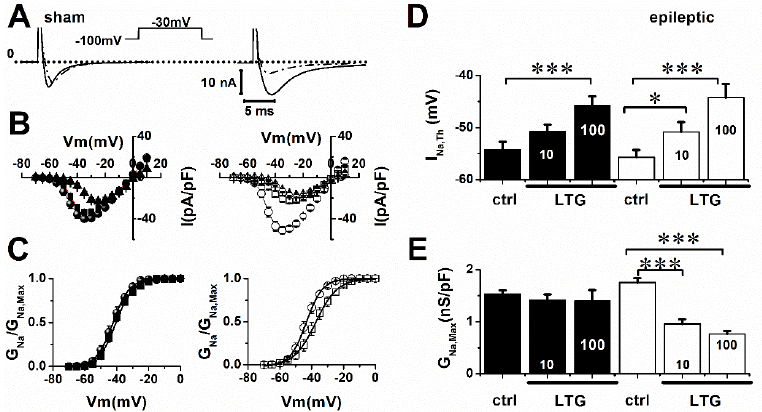
Figure 1. LTG blockade of I Na is increased during epilepsy. ( A ) Inset: voltage clamp protocol. I Na currents were activated by 25 ms voltage steps from −70 to 10 mV, in 5 mV increments, from a −100 mV holding potential. Representative I Na recordings from sham and epileptic rat ventricular cardiomyocytes in control conditions (solid line), and in presence of 10 µmol/L of LTG (dash-dot line). ( B ) Current – voltage relationships (I/V) for sham (filled symbol) and epileptic (open) animals in control conditions (circle), 10 µmol/L (square) and 100 µmol/L of LTG (triangle). ( C ) Normalized I Na activation curves for control and 10 µmol/L of LTG. Data points (±SEM) were fitted to a Boltzmann equation (solid lines). ( D ) LTG (10 µ mol/L) depolarized I Na voltage threshold (I Na,Th ) only in epileptic animals, while 100 µ mol/L of LTG significantly depolarized I Na,Th in both groups. Each bar represents average values ( ± SEM) in control conditions and upon addition of 10 and 100 µ mol/L of LTG. ( E ) LTG decreased Na + channel conductance (G Na,Max ) in epileptic animals. Average values of G Na,Max in same conditions as ( D ). Tukey test using one-way ANOVA (ctrl vs. LTG), * indicates p < 0.05, *** indicates p < 0.001. Number of cells: Sham (ctrl, LTG): 13, 14. Epileptic (ctrl, LTG): 14, 13.